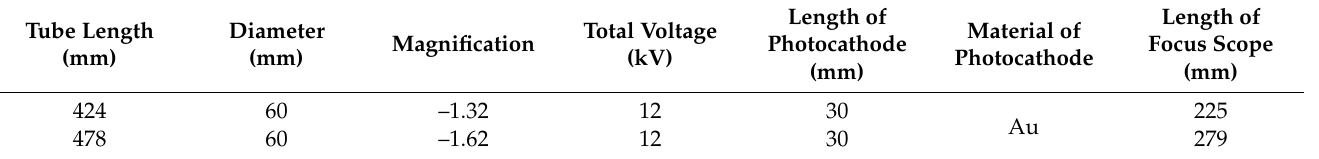
Table 1. Structural parameters of streak